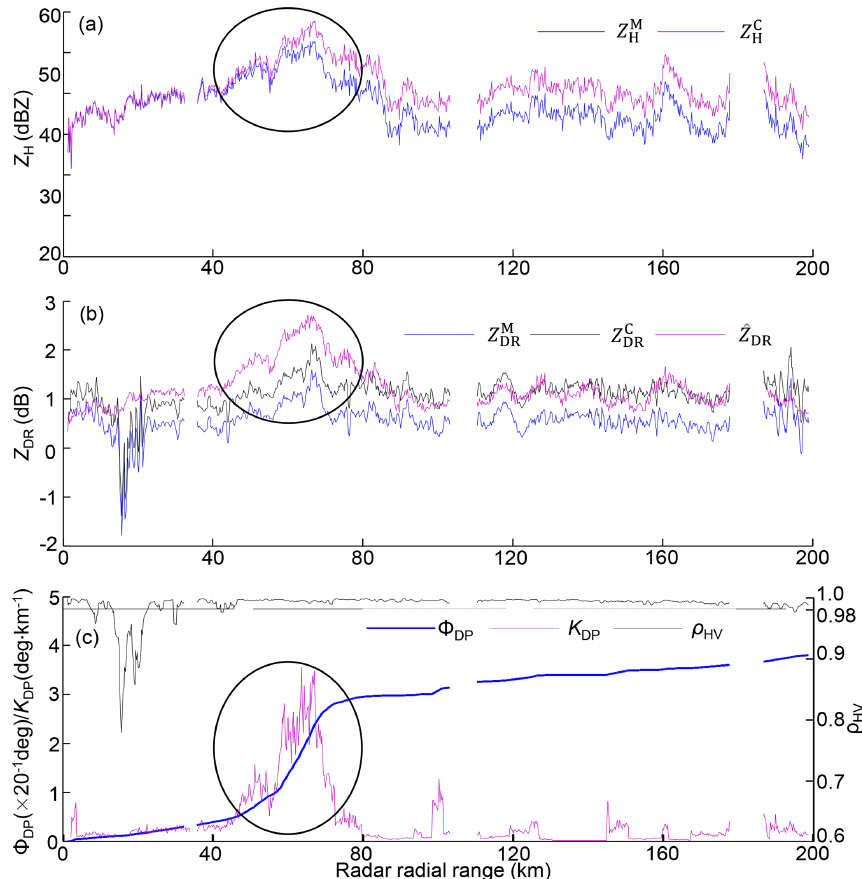
Figure 18. The WZ-SPOL radar along a radial profile (azimuth angle = 46 ◦ ) at an elevation angle of 0.5 ◦ at 17:59UTC, 9 August 2019: (a) Z C and Z M ; (b) Z M , Z C , and ˆ Z DR ; and (c) (cid:56) DP , K DP , and ρ HV . This azimuth angle is marked in Fig. H H DR DR